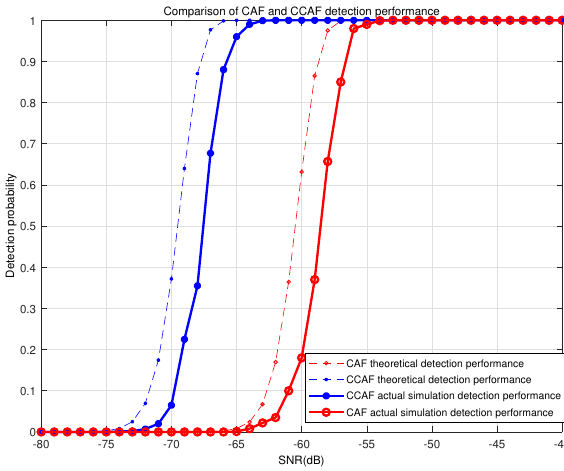
Figure 14. Comparison of detection performance between CCAF and CAF.